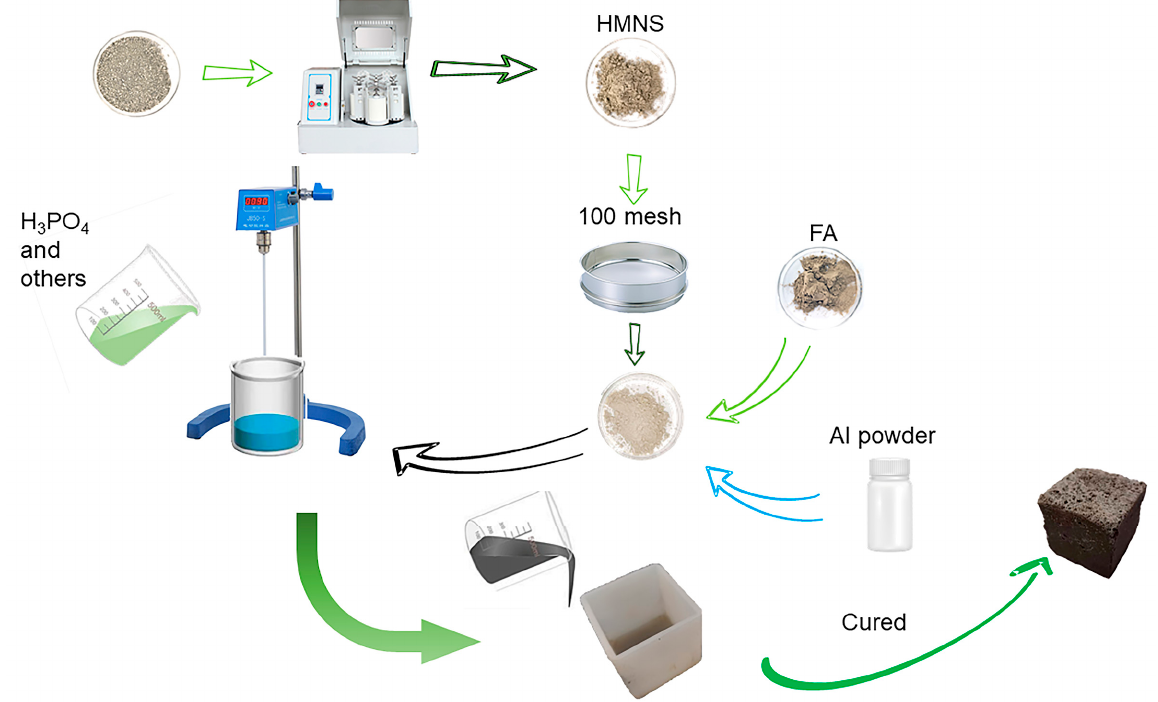
Figure 3. Preparation process of porous geopolymers.